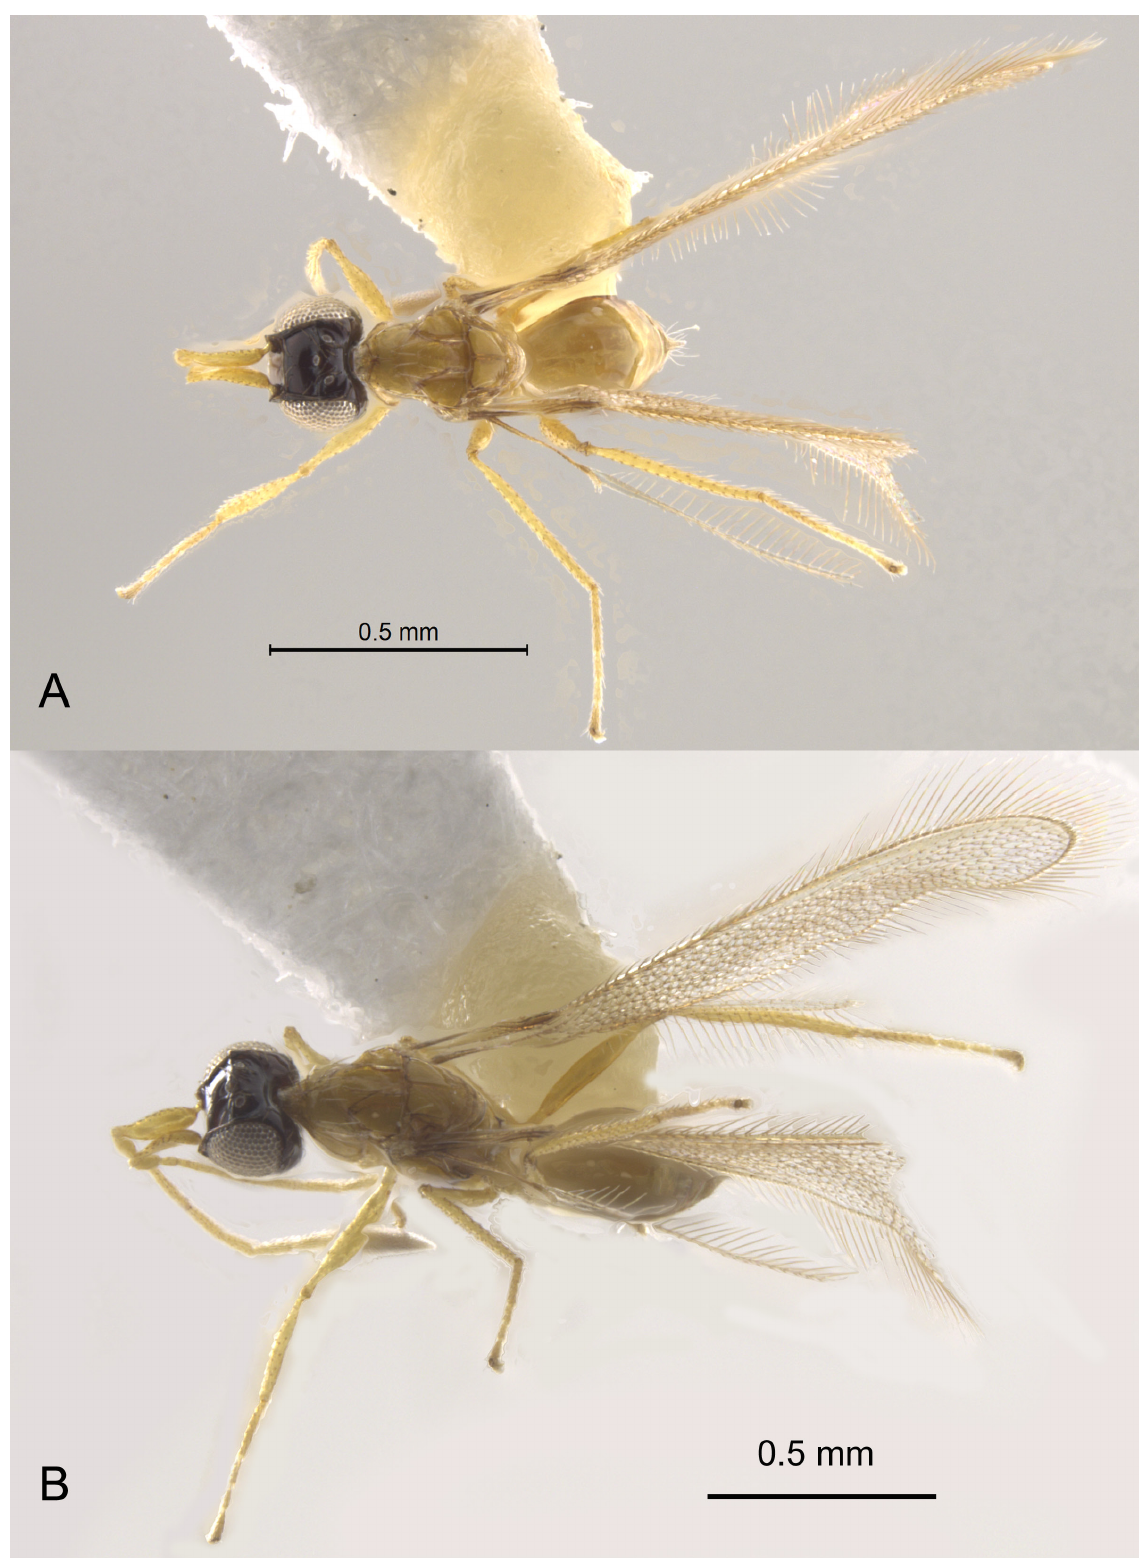
Fig. 13. Ganomymar zuparkoi sp. nov., ♀, paratype (CAS). A . Habitus in dorsal view. B . Habitus in dorsolateral